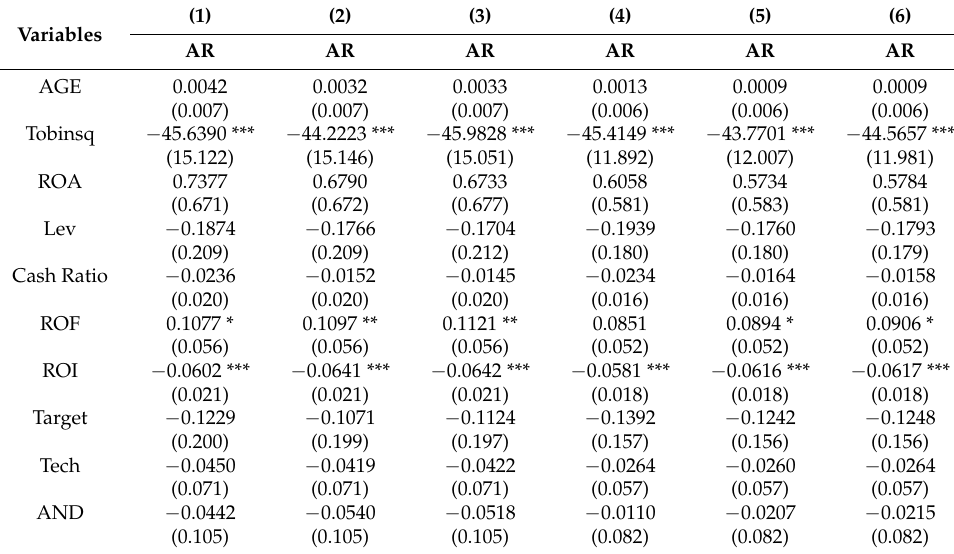
Table 10. Robustness checks on alternative independent